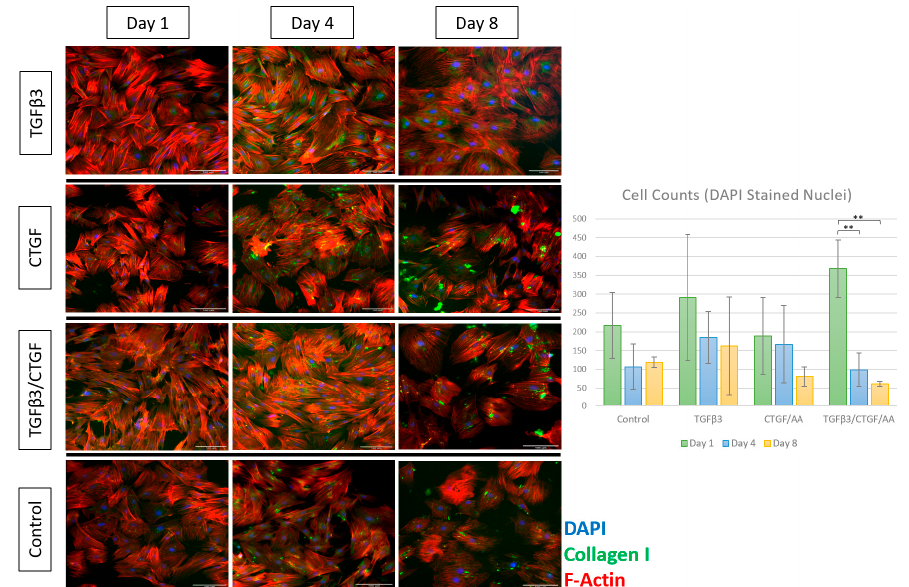
Figure 4. Expression of collagen Type I (green) and F-actin (red) in rAdMSCs exposed to TGF- β 3 (10 ng/mL), CTGF (100 ng/mL) with 50 μ g/mL ascorbic acid, or TGF- β 3 (10 ng/mL), CTGF (100 ng/mL), and 50 μ g/mL ascorbic acid at Days 1, 4, and 8 of culture; cell nuclei counterstained with DAPI (blue). Mean values of DAPI-stained nuclei counts are depicted in the accompanying chart; cell counts significantly decreased between Day 1 and Days 4 and 8 in the group treated with TGF β 3/CTGF/AA. Scale bar = 100 μ m. “**” represents p < 0.01 in pairwise comparison. Figure 1. Histological grading scale as described by de Girolamo et al. (2019) [59]. Bioengineering 2022 , 9 , x FOR PEER REVIEW No significant differences in the proportion of cells displaying tenascin C immuno- fluorescence to the total cell counts were observed between the treatment groups on Days 1 and 4 (Figure 5); however, both the TGF- β 3 and CTGF/AA groups exhibited increased tenascin C expression on Day 8 when compared to unexposed controls ( p = 0.0185 and p = 0.0188, respectively). This can be attributed to a marked decrease in Tenascin C expression in the control cells compared to sustained upregulation in the TGF- β 3 and CTGF/AA groups. In addition, cells exposed to TGF- β 3 exhibited a unique but consistent tenascin C immunofluorescent signature characterized by high intensity fluorescence encircling the nucleus and moderate intensity fluorescence adjacent to the cell membrane; this signature was most apparent at Day 4 of culture but could be noted at all timepoints in the TGF- β 3 group.